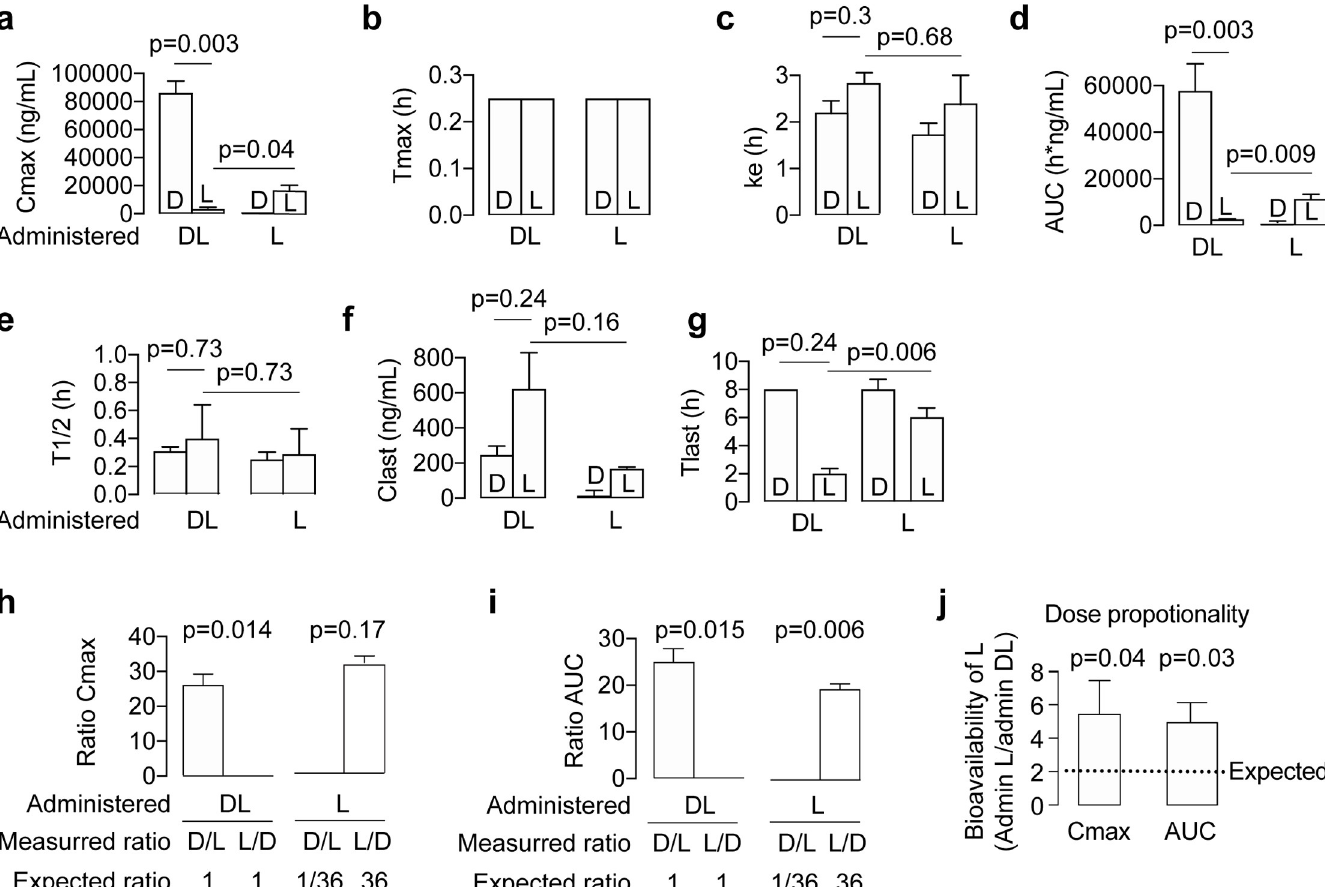
Fig 5. Bar charts showing the pharmacokinetic parameters for the enantiomers of N-acetyl-L-leucine after administration of racemic N-acetyl-DL-leucine (denoted as DL) or N-acetyl-L-leucine (denoted as L). ( a-g ) Conventional pharmacokinetic parameters calculated from the plasma concentration of drug. ( h-j ) Parameters derived from the conventional pharmacokinetic parameters to detect and highlight the effects of pharmacokinetic differences between the enantiomers. Values are the mean ± standard error of the mean with n = 3 (mice). Means were statistically analysed by either ( a-g ) pre-planned t tests; ( h and i ) a one-sample t test comparing the measured value with the expected value: 1 when administered as DL and 36 when administered as purified L; and ( j ) a one-sample t test comparing the measured value with the expected value of 2. The means compared are indicated by the horizontal lines on the charts, and exact p values are provided for the